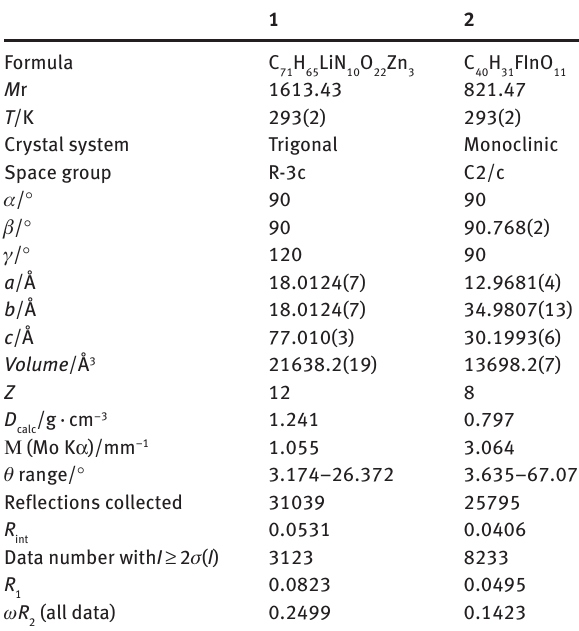
Table 1: The crystalline data and refinement parameters for com- plexes 1 and